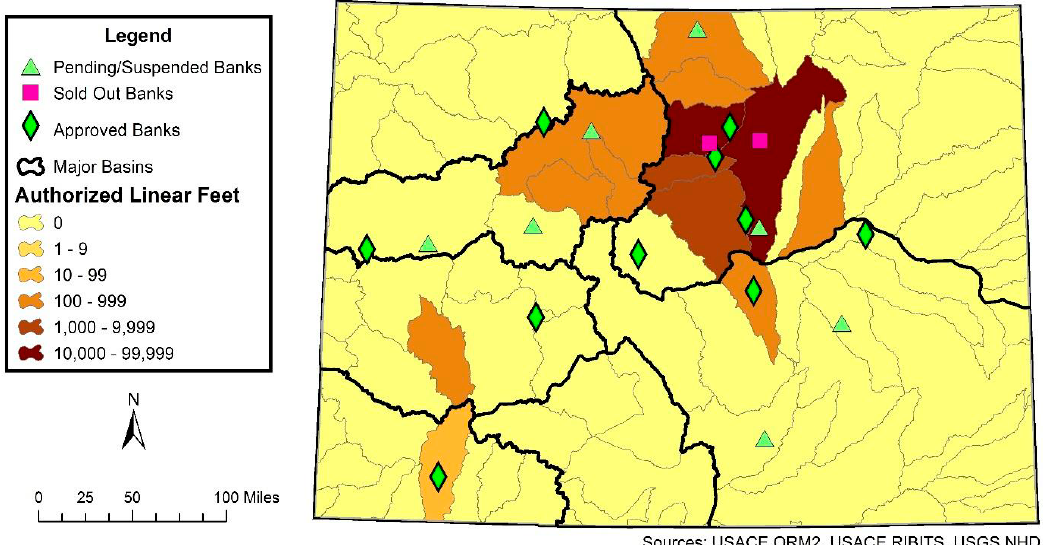
Figure 3. Authorized linear feet (LF) of permanent riverine impacts requiring compensatory mitigation by